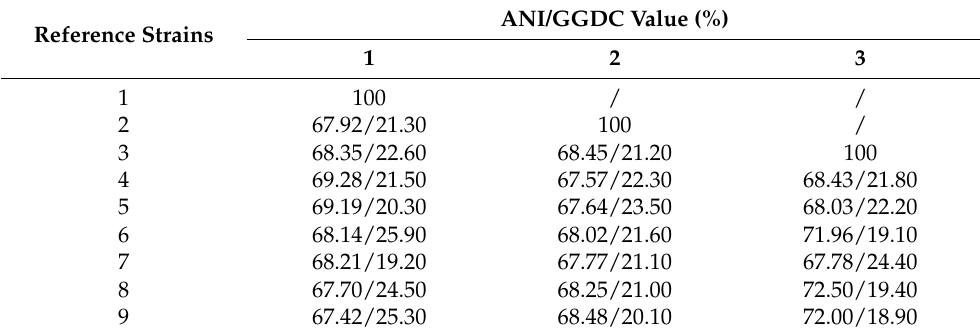
Table 5. Genomic similarities (%) of ANI and GGDC Values between the three isolated strains and other relatives type species in the genus Paenibacillus . (1) Paenibacillus endoradicis T3-5-0-4, (2) Paenibacillus radicibacter N1-5-1-14, (3) Paenibacillus radicis N5-1-1-5, (4) Paenibacillus